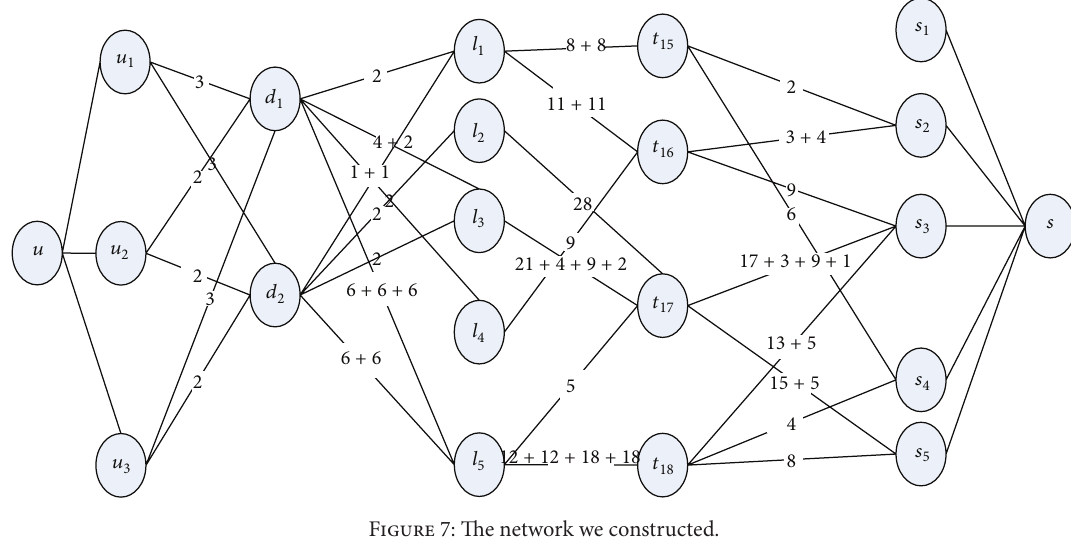
Figure 7: The network we constructed.